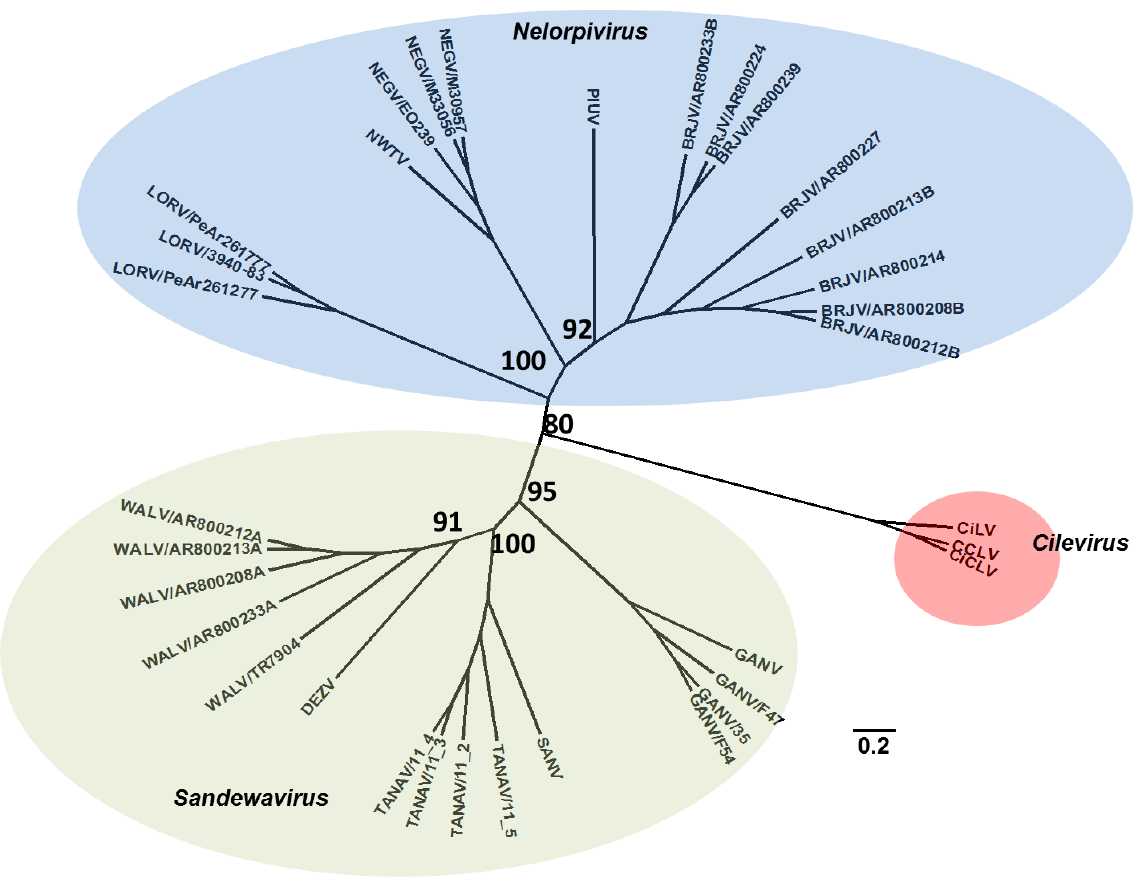
Figure 5. Negeviruses: Maximum likelihood analysis of select negeviruses. The region of the genome corresponds to the nt 4316–7309 (Negev E0239), which corresponds to the RNA-dependent RNA-polymerase of the genome. Branch labels indicate virus abbreviation/strain. Additional virus isolate information is contained in a supplemental file.